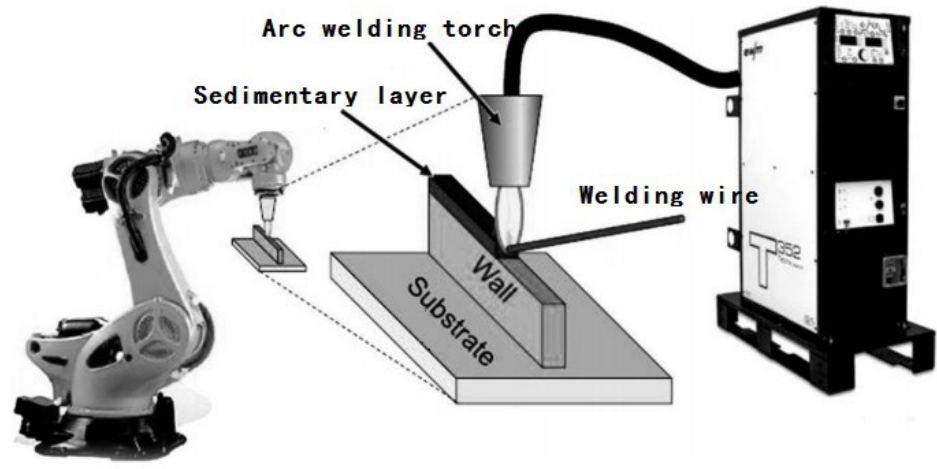
Figure 1. WAAM technology process.